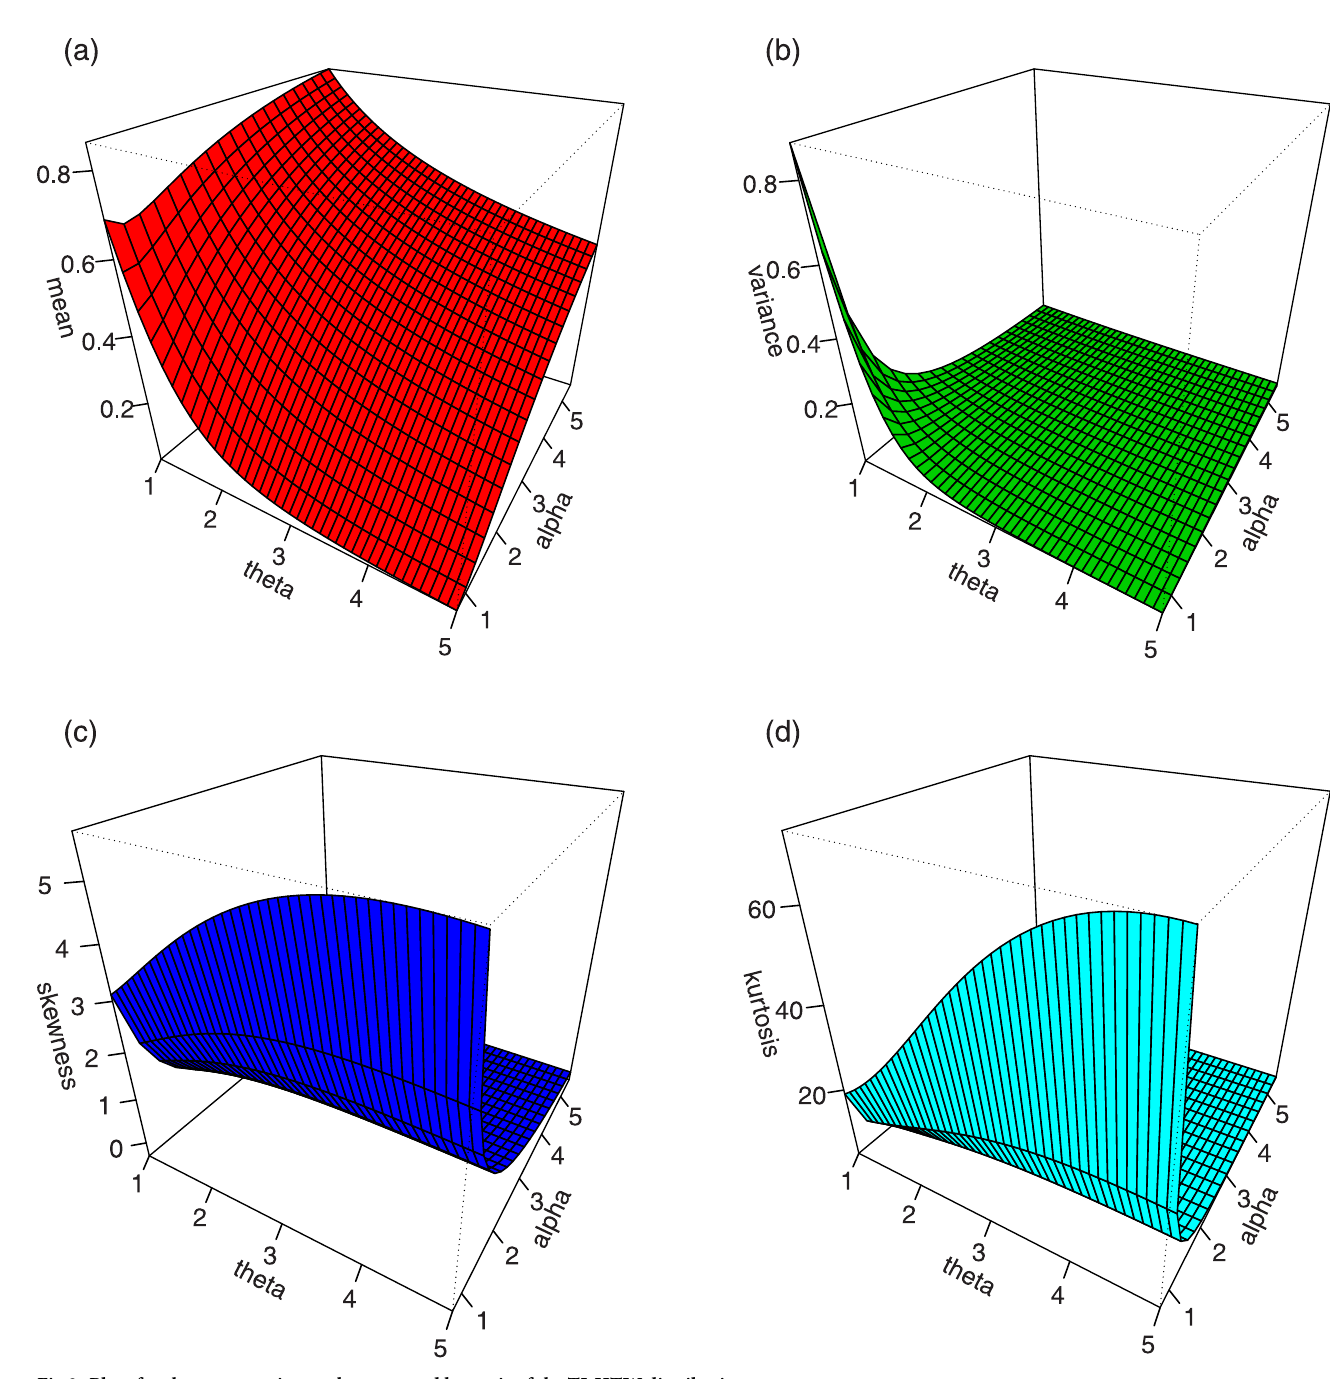
Fig 3. Plots for the mean, variance, skewness and kurtosis of the TI-HTW distribution.